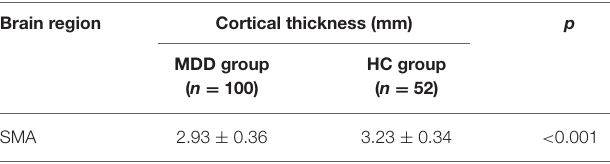
TABLE 4 | Cortical thickness of SMA in the right hemisphere of MDDs and HCs at